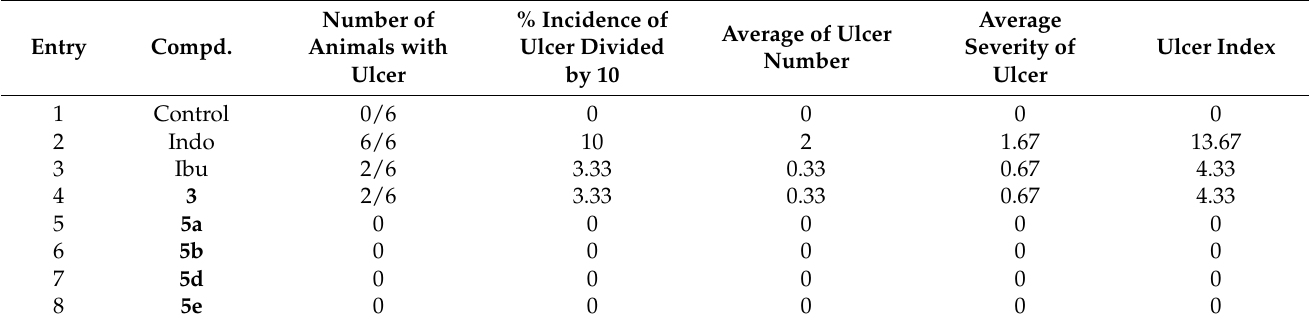
Table 4. Ulcerogenic liability of the tested